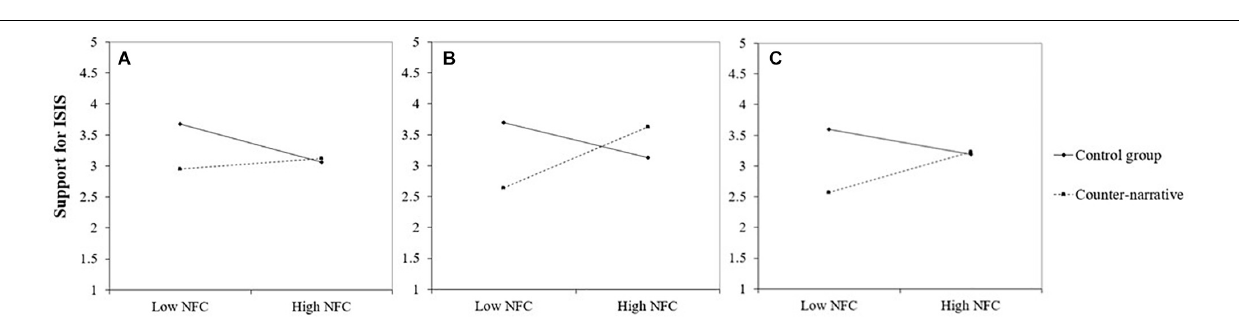
FIGURE 3 | Support for ISIS as a function of Muslims’ need for closure and exposure to a social counter-narrative (vs. control message) delivered by (A) the United States Government, (B) an ISIS defector, and (C) an Imam. All interactions are significant, except (A) which, though in the expected direction, was not significant. Low NFC = − 1 SD; High NFC = + 1